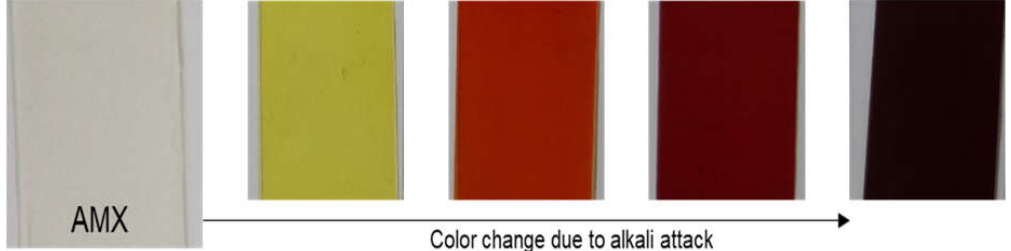
Figure 2. A color change trend of commercial AMX during the alkali immersion test.